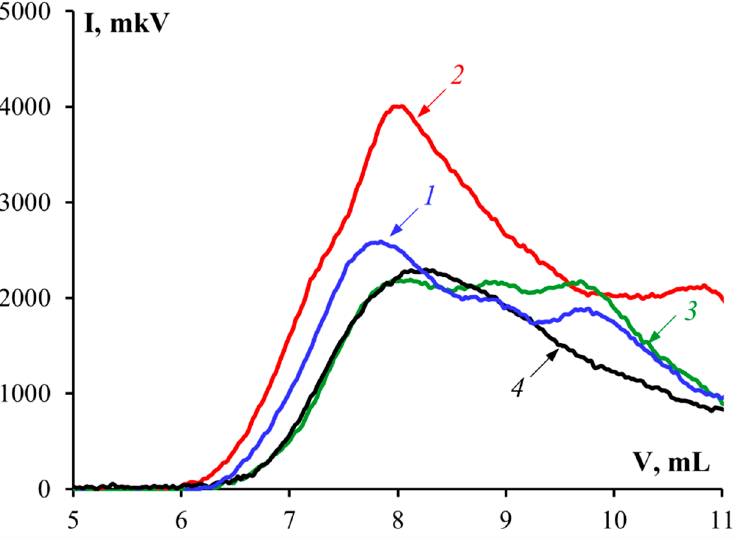
Figure 1. Chromatograms of gelatin samples: 1—G1, 2—G2, 3—G3, 4—G 7041.